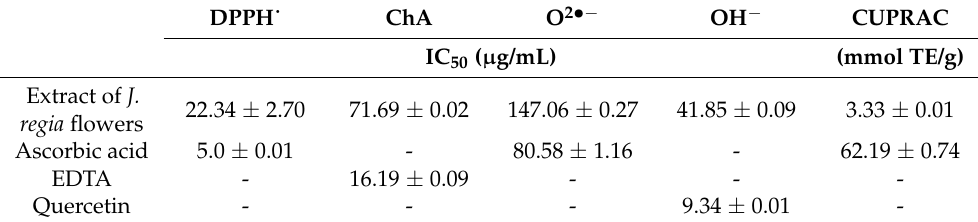
Table 2. Antioxidant activities of J. regia male flowers extracts and standards.